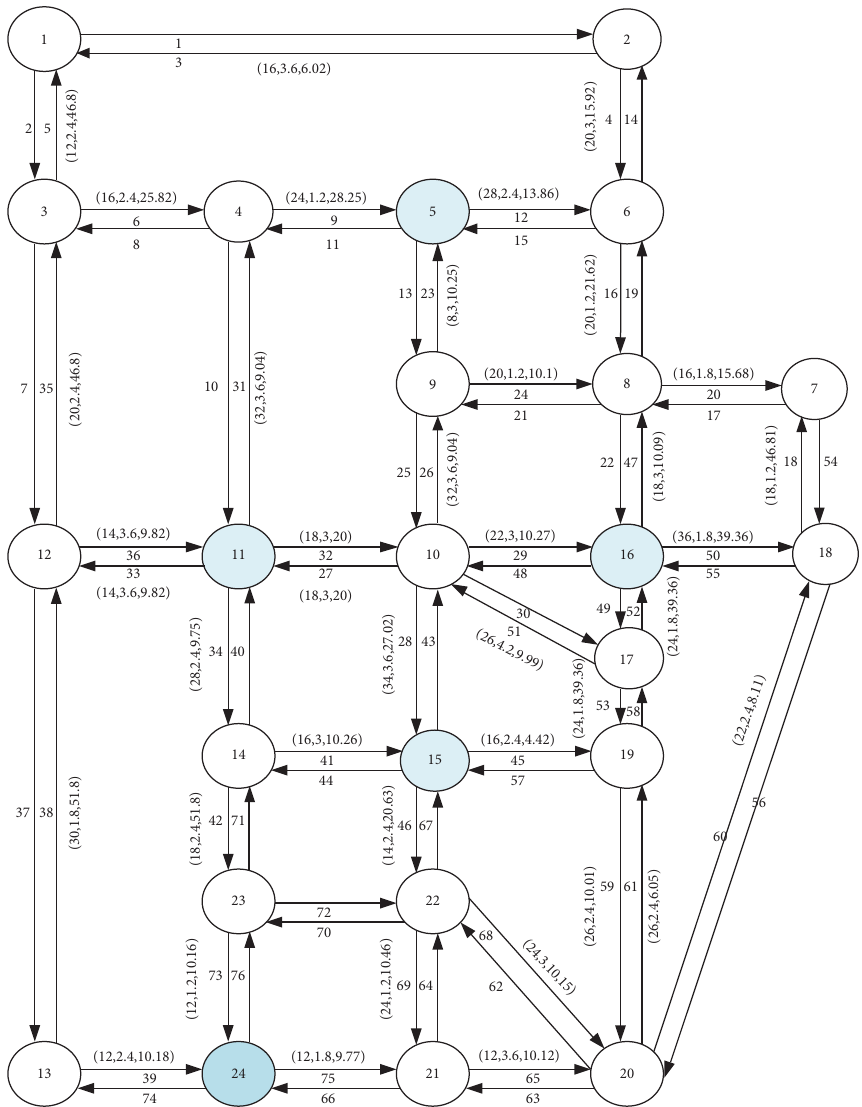
Figure 3: Sioux Falls network (colorflled node denotes